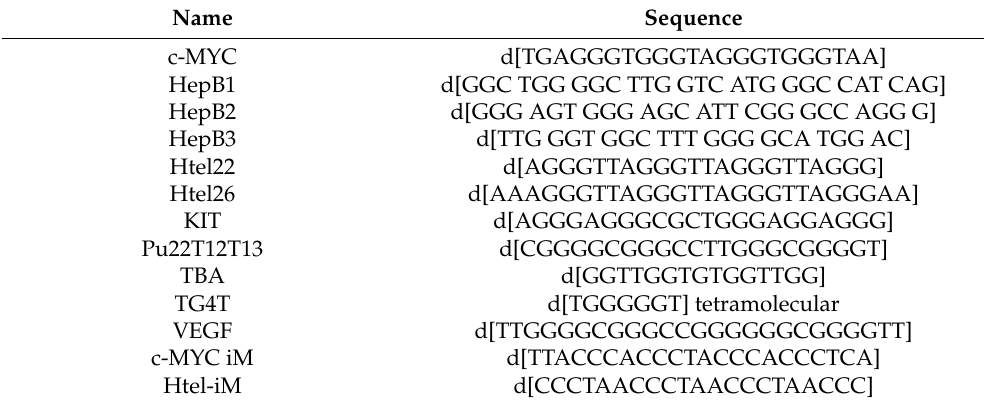
Table 1. The DNA sequences of the oligos reviewed in this paper.